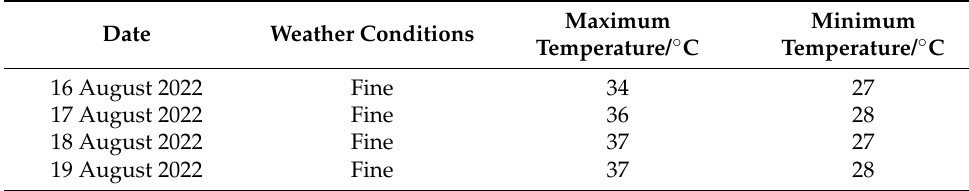
Table 4. Atmospheric temperature data.